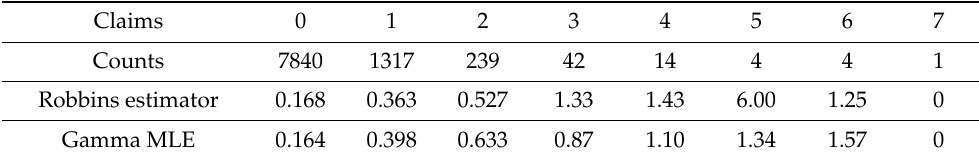
Table 1. Table reporting, in the second line, the exact counts of claimed accidents. Third and fourth lines display estimated numbers of